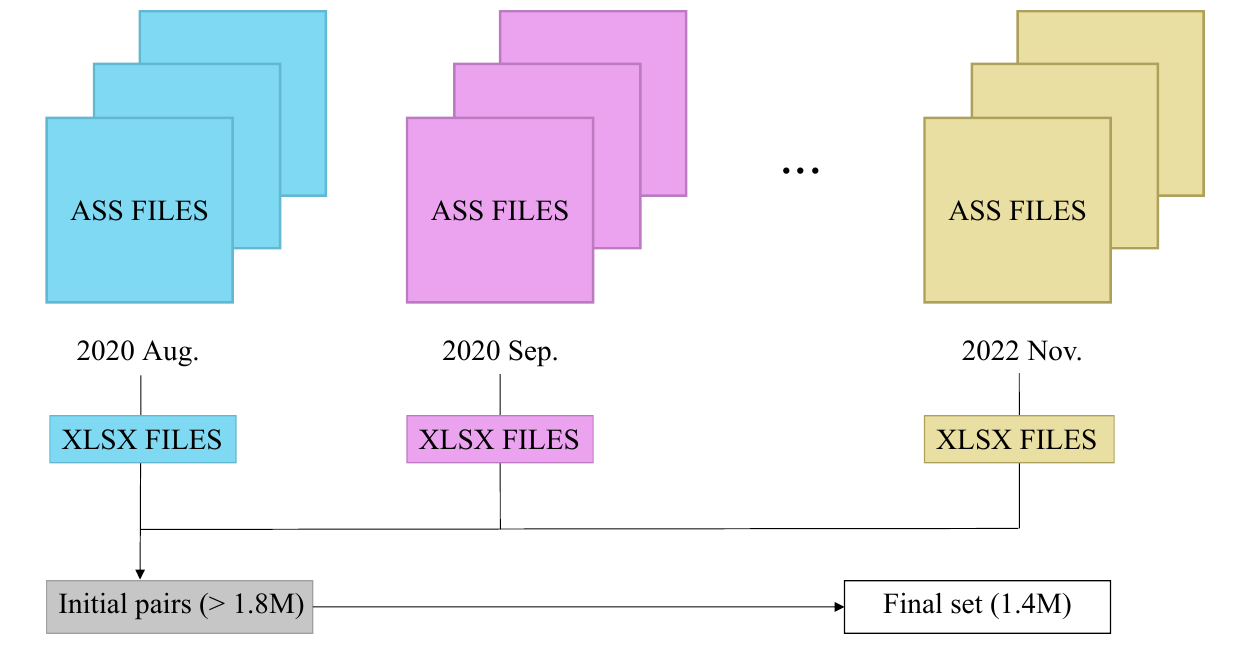
Figure 1. The timeline of manually aligning WCC-JC 2.0.